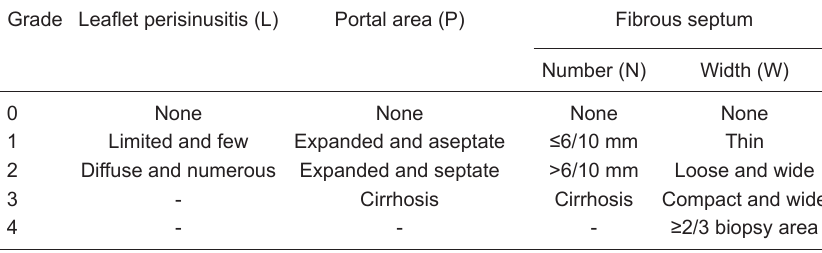
Table 4. Semi-quantitative scoring system (SSS) for fibrosis. Grade Leaflet perisinusitis